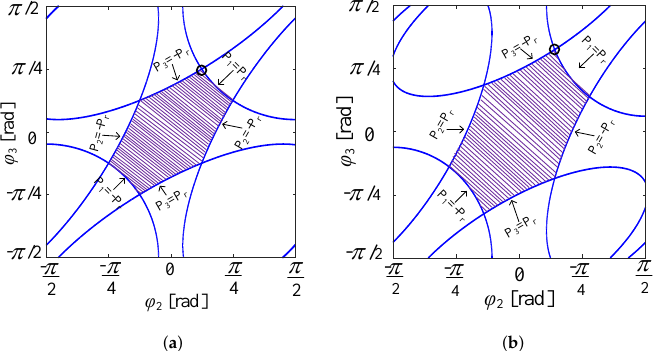
Figure 8. Phase shift operation of TAB converter in two different voltage states: ( a ) V 1 , V 2 , and V 3 are all 100%, ( b ) V 1 and V 2 are both 100%, V 3 is 80%.